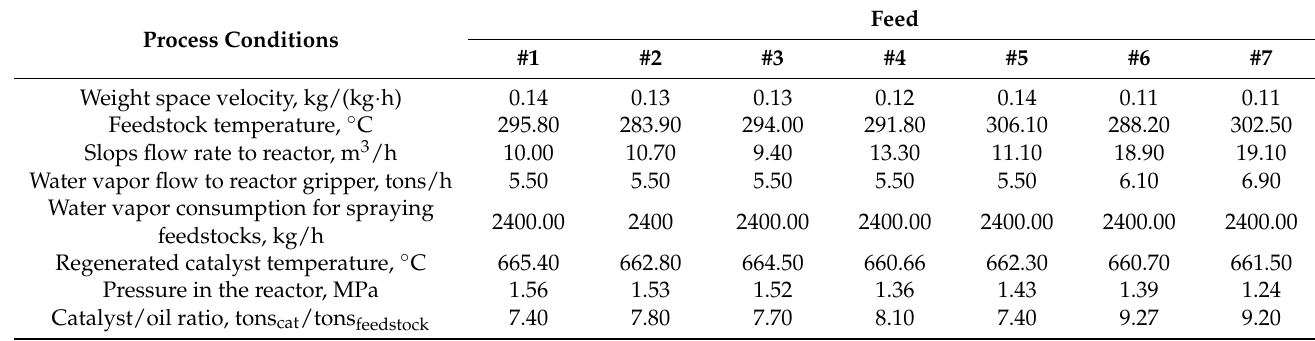
Table 3. Operating variables of the catalytic cracking riser (industrial data).